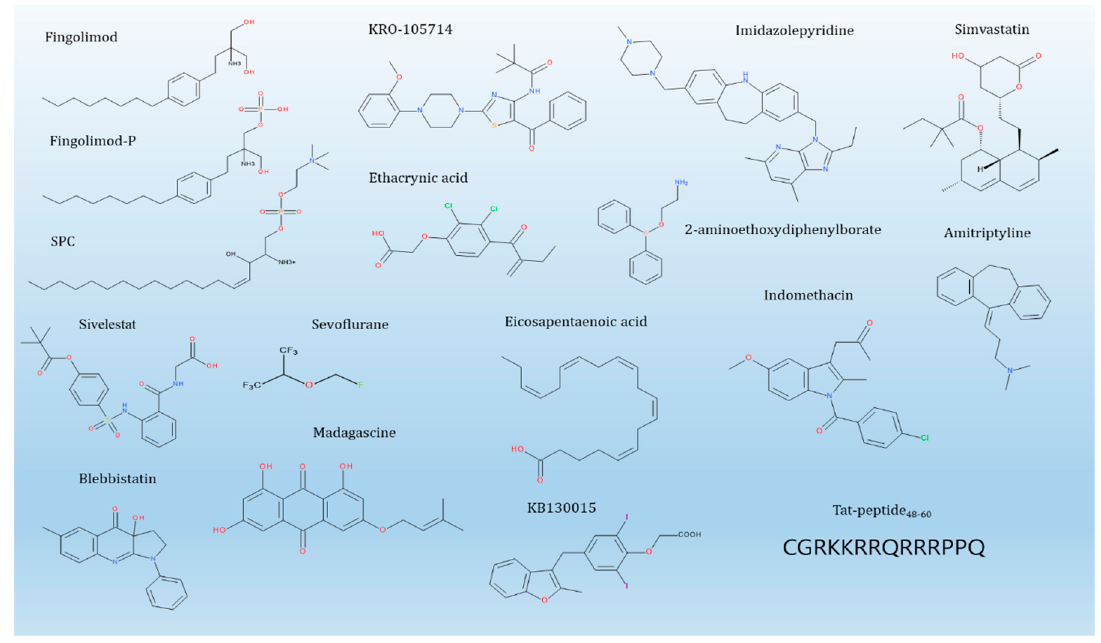
Figure 3. SPC and its blockers.